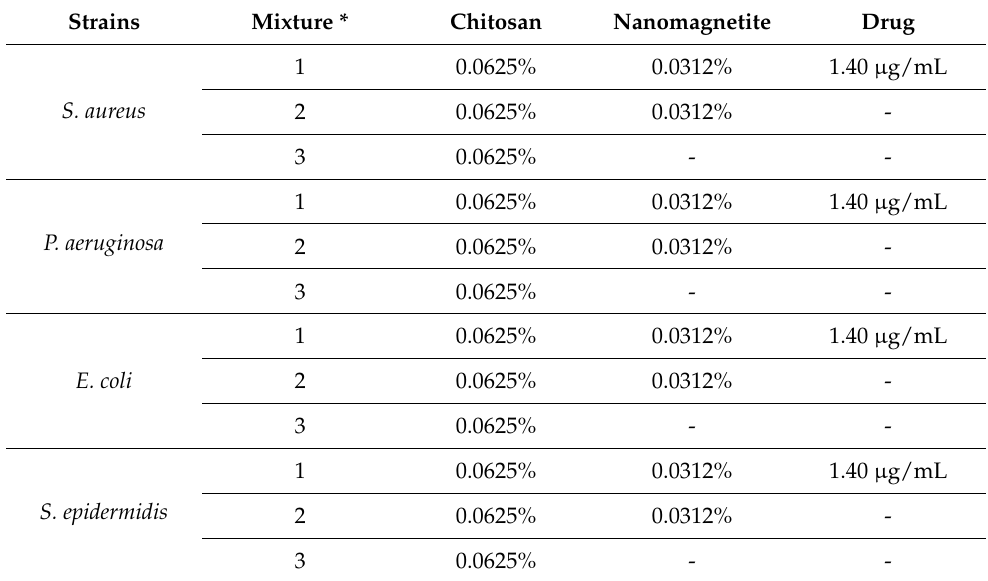
Table 8. Summary of MIC values for each component and mixtures. Strains Mixture